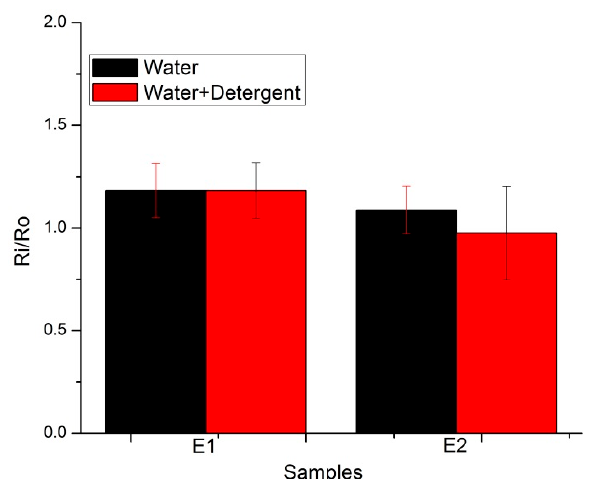
Figure 17. Surface resistance analysis with immersion in solutions (E1-E2 electrodes).